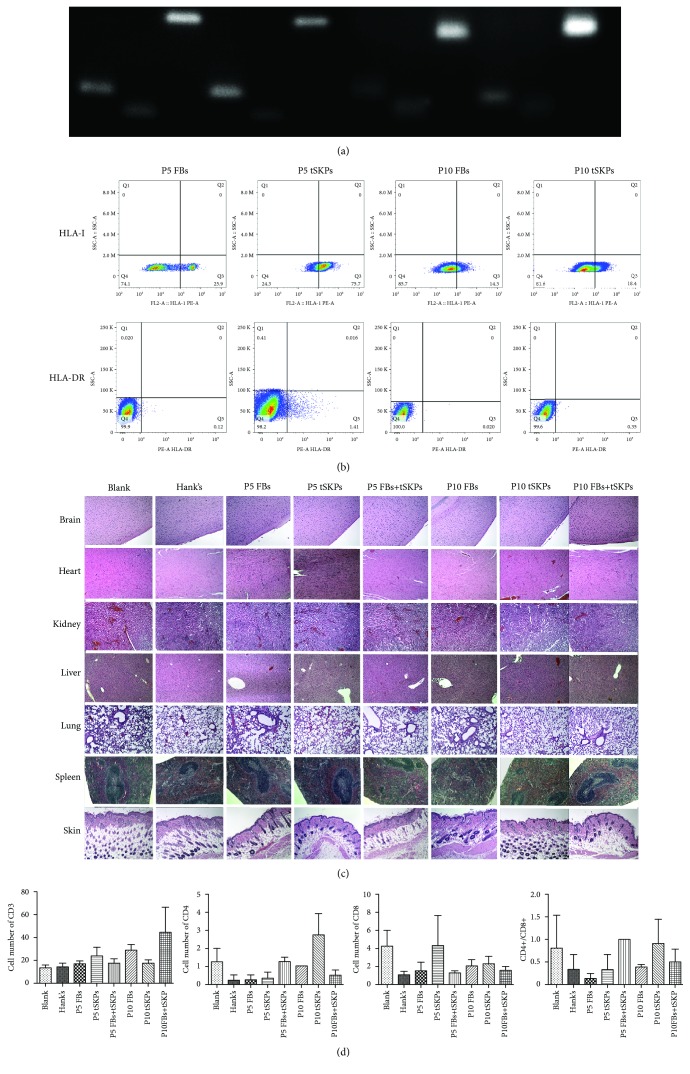
Analysis of biological safety for FBs and tSKPs. (a) RT-PCR analysis for the expression of HLA-I, HLA-DR, and, as a control, GADPH in FBs and tSKPs that had been passaged five and ten times. (b) Flow cytometer analysis for the surface marker expression of HLA-I, HLA-DR, and, as a control, GADPH in FBs and tSKPs that had been passaged five and ten times. (c) Effect of FBs and tSKPs to SCID mice on anatomic pathology. HE staining revealed that all organs from different groups showed normal histology. (d) Effect of FBs and tSKPs to SCID mice on the subpopulation of T lymphocytes. No significant change in the subpopulation of T lymphocytes. The values are expressed as mean ± SD.